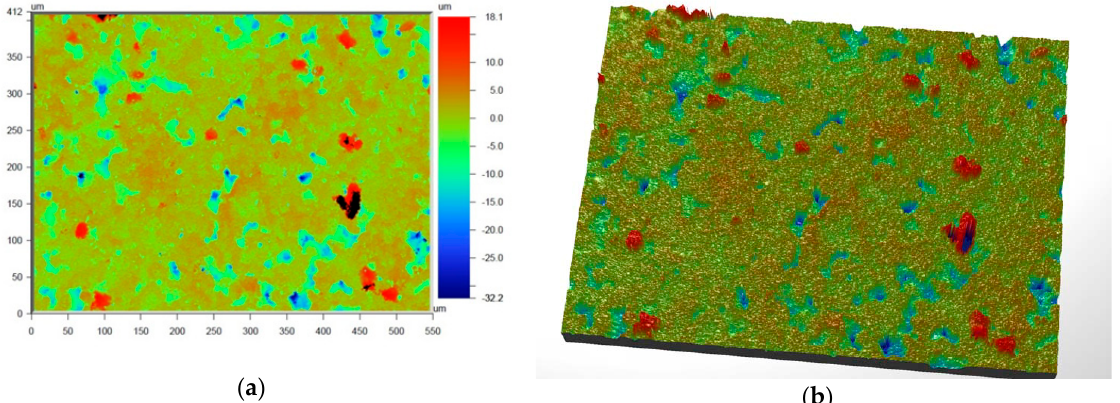
Figure 9. 2D ( a ) and 3D ( b ) profilographs of PW1 sample at a magnification of ×11.5.